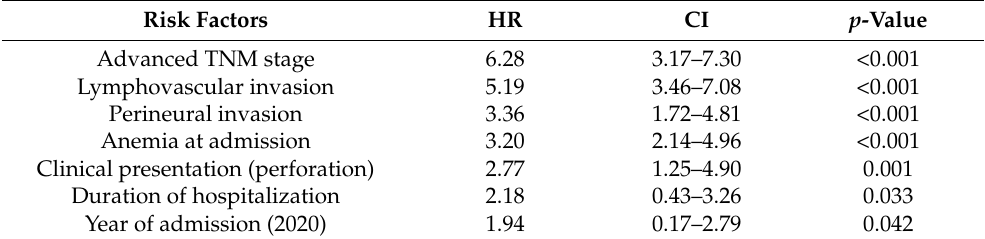
Table 4. Risk factors for colorectal cancer progression after the initial hospital visit.